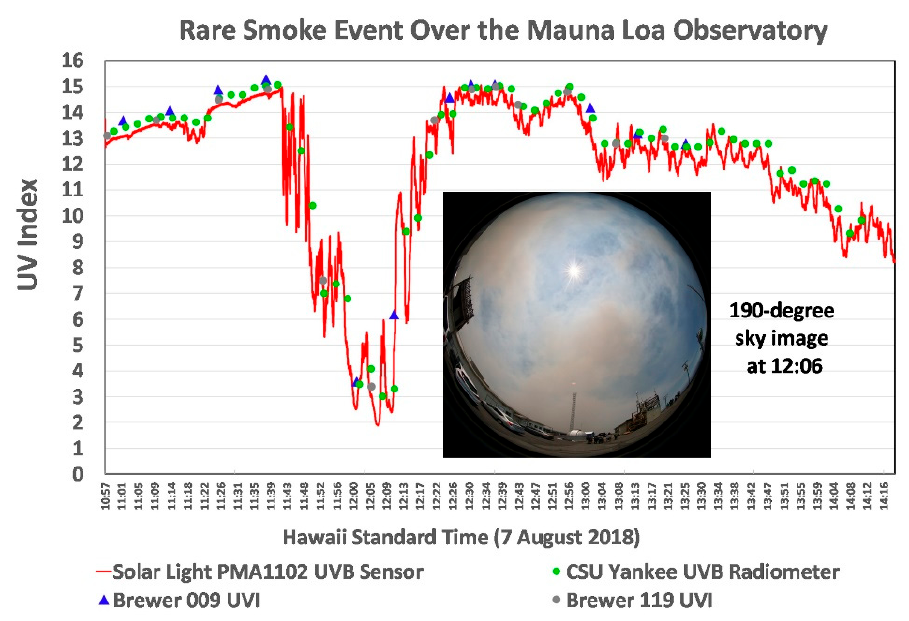
Figure 12. UVI measured by four instruments during a rare smoke event just before solar noon at the Mauna Loa Observatory. The Brewer data are preliminary.